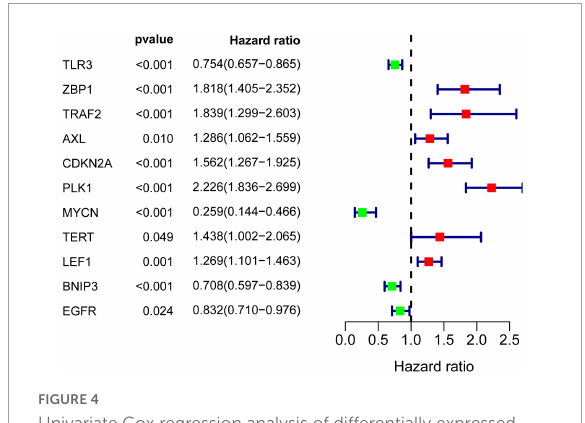
( Figure 4 ). Thereafter, 4 NRGs were selected via multivariate Cox regression analysis for constructing a prognostic signature for OS ( Table 1 ). OS-related prediction model = (0.2407 ∗ TRAF2